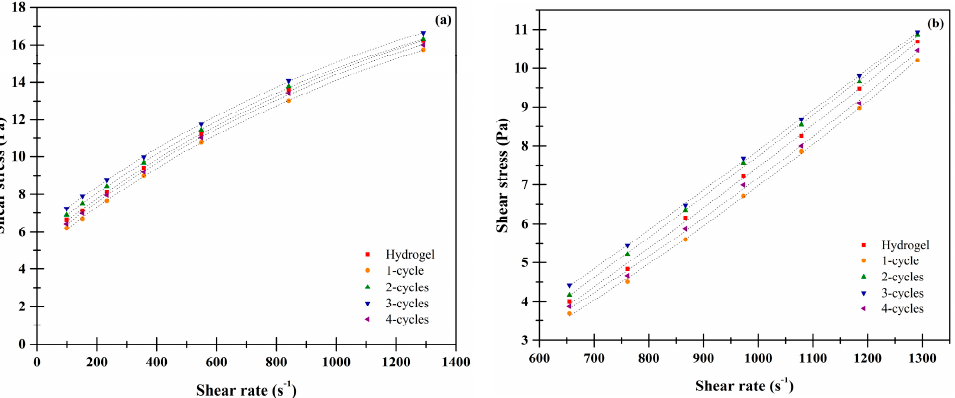
Figure 9 Figure 9. Rheological behavior of the hydro- and cryogels. ( a ) xanthan; ( b )